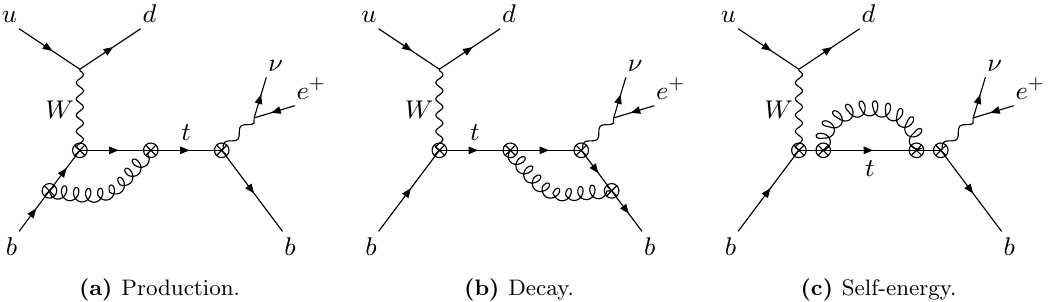
Figure 3. NLO virtual contribution to the (a) production vertex, (b) decay vertex, or (c) top-quark self-energy. Each crossed circle represents a possible SMEFT operator